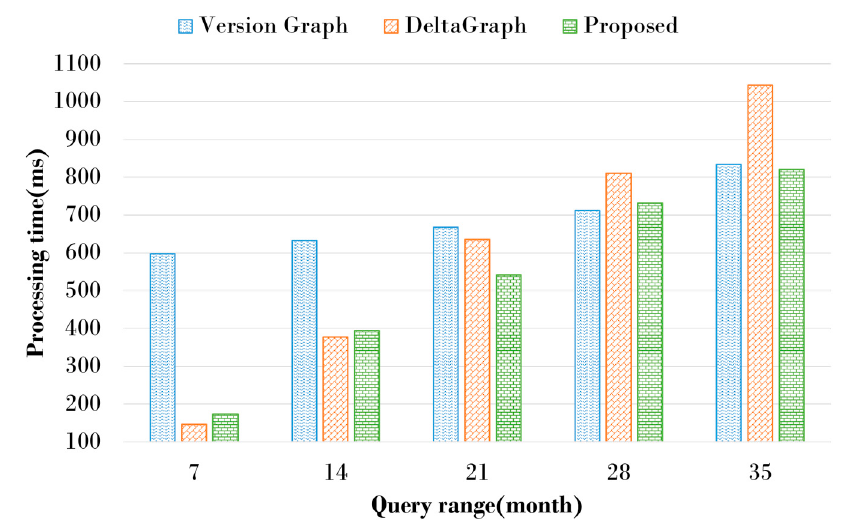
Figure 14. Query processing time according to the query range.